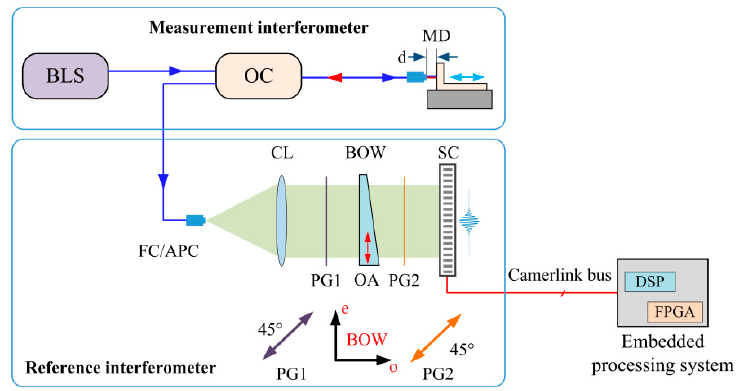
Figure 1. Schematic diagram of measurement and reference interferometer of a typical PLCI.